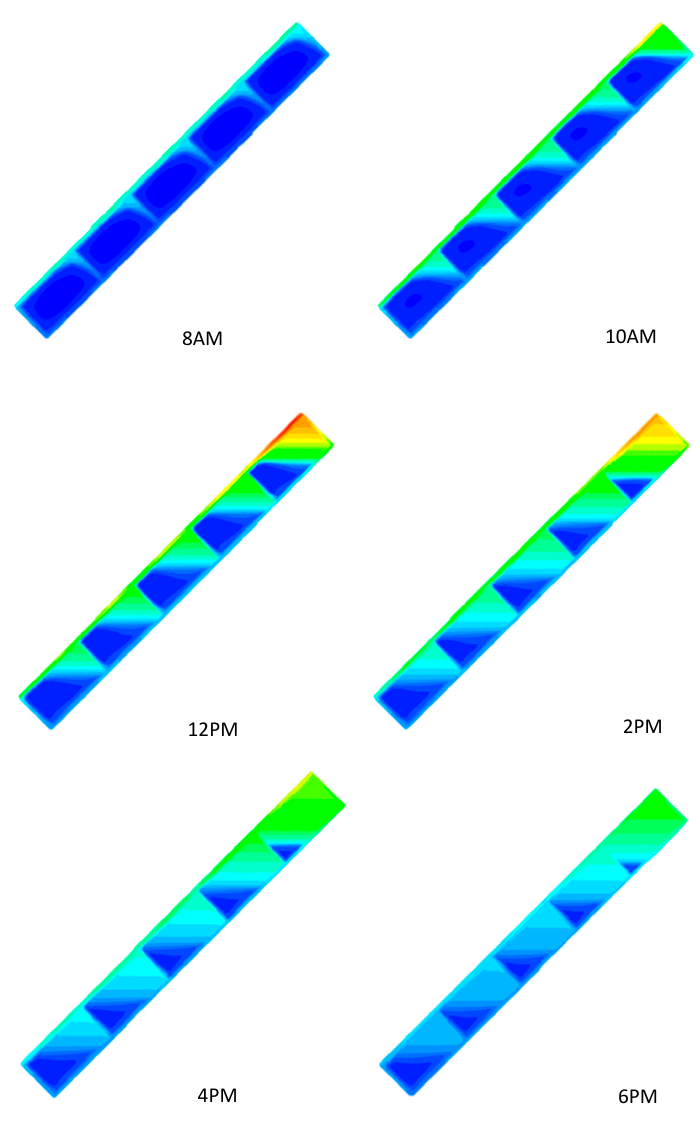
Figure 4. Temperature contours of the FPCM cooled system.